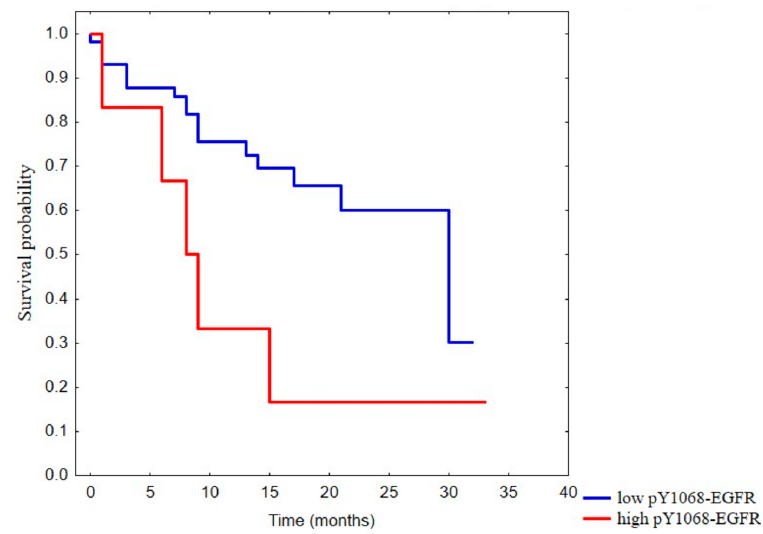
Figure 2. Disease-specific survival (DSS) according to pY1068-EGFR positivity. Kaplan–Meier plots of overall survival according to the groups of low (blue) or high (red) pY1068-EGFR levels ( p = 0.036).